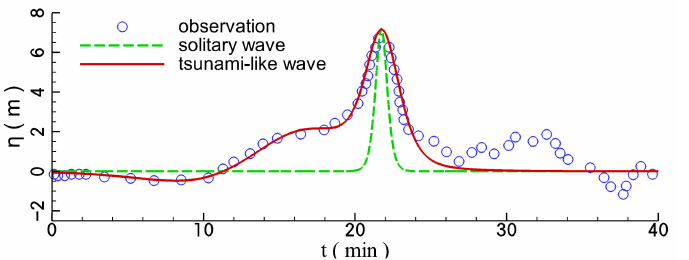
Figure 1. Comparison of the time series of wave profiles from field observation, solitary wave, and tsunami-like